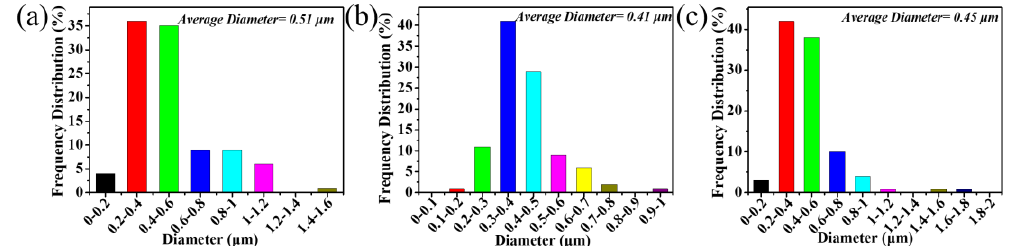
Figure 2. Diameters of electrospun fibers prepared with different concentration spinning solutions. ( a ) 20 wt.%, ( b ) 24 wt.%, ( c ) 28 wt.%.